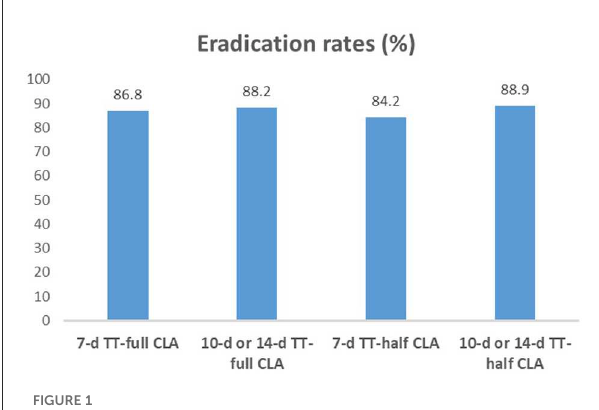
FIGURE1 H. pylori eradication rates in each group. The eradication rates were not significantly different among the four groups ( P > 0.05). In 7-day TT, there was no significant difference in the eradication rates between TT-full CLA (86.8%) and TT-half CLA (84.2%, P = 0.806). Moreover, in 10-day or 14-day TT, there was no significant difference in the eradication rates between TT-full CLA (88.2%) and TT-half CLA (88.9%, P >